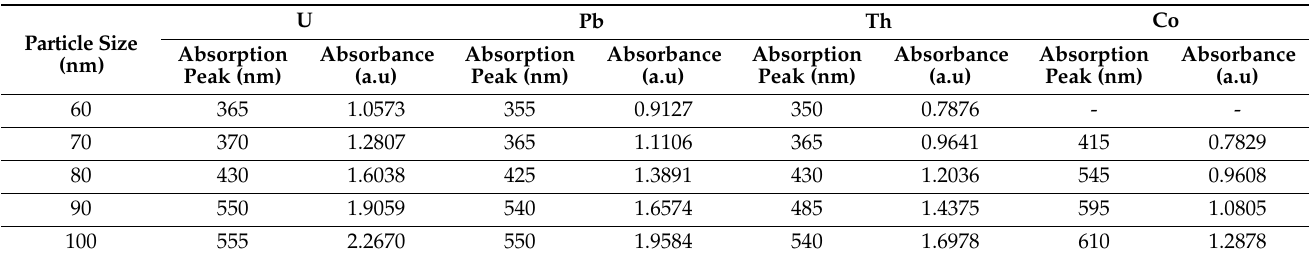
Table 1. The COMSOL-simulated maximum absorption peak of U, Pb, Co, and Th nanoparticles for different particle